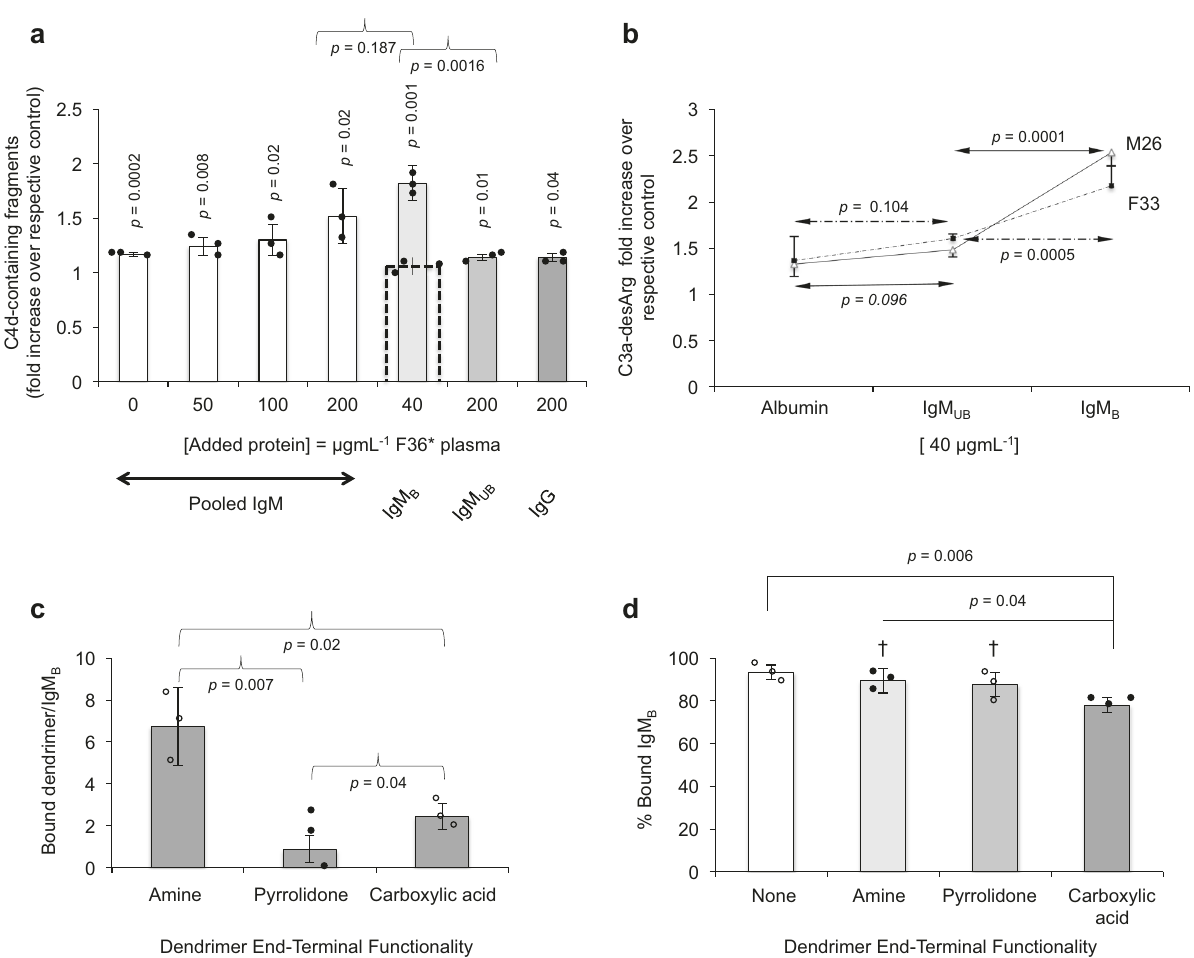
Fig. 3 Natural IgM molecules bind to dendrimers and trigger complement activation through the lectin pathway. a Increasing concentrations of human IgM in F36* plasma (F36 plasma reconstituted with MBL-MASPs; equivalent to 3 µ g MBL mL − 1 ) elevates levels of C4d-containing activation fragments of C4 in the presence of amine-terminated G5 dendrimers. IgM B = IgM glycosylated variants that bind to MBL, and IgM UB = IgM variants that are not retained by agarose-MBL. Liberation of C4d-containing activation fragments of C4 is inhibited by 10 mM EGTA/2.5 mM Mg 2 + (the broken-line overlay column). Bars represent mean values ± s.d. of three technical replicates, and each in triplicate samples. The p values (unpaired, two-sided) represent comparison of each treatment with their corresponding controls (plasma incubations without dendrimers, but in the presence of all other additives); otherwise indicated. b Complement activation (as a measure of C3a-desArg elevation) in two IgM-depleted plasma samples is restored on addition of IgM B (40 µ gmL − 1 ). The points are mean of three separate experiments ± s.d. and each experiment was done in triplicate samples. Differences between groups were examined using ANOVA followed by multiple comparisons with Student – Newmann – Keul test. In a and b , the dendrimer concentration is 0.132 mM. c Estimation of dendrimer binding to IgM B . d Binding of dendrimer-IgM B complexes to agarose-MBL. In panels c and d , bars show mean values± s.d. of three technical replicates, and each in triplicate samples. † p > 0.2, compared with “ no dendrimer ” (IgM B only). Source data are available in Source data fi